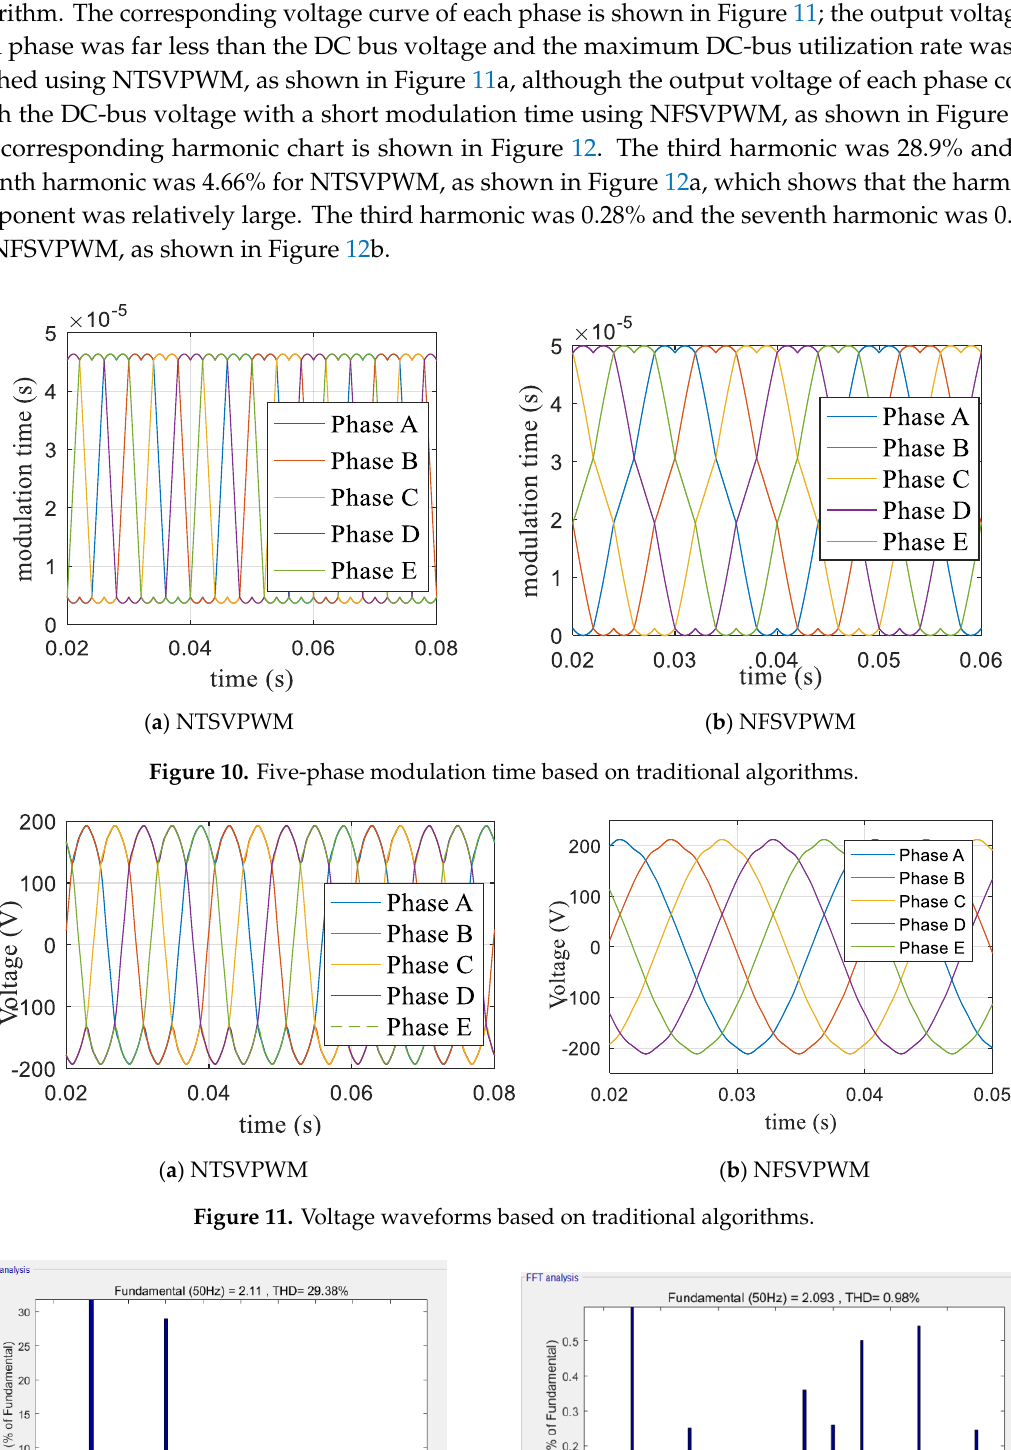
Figure 9. Five-phase motor simulation model based on Matlab/Simulink.